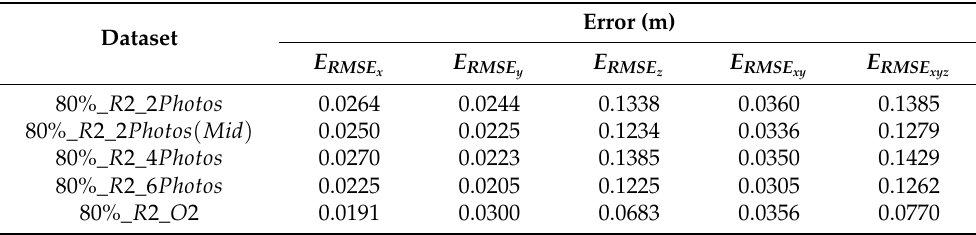
Table 7. 3D scenes accuracy assessment results of 4 different oblique imaging numbers and posi- tion